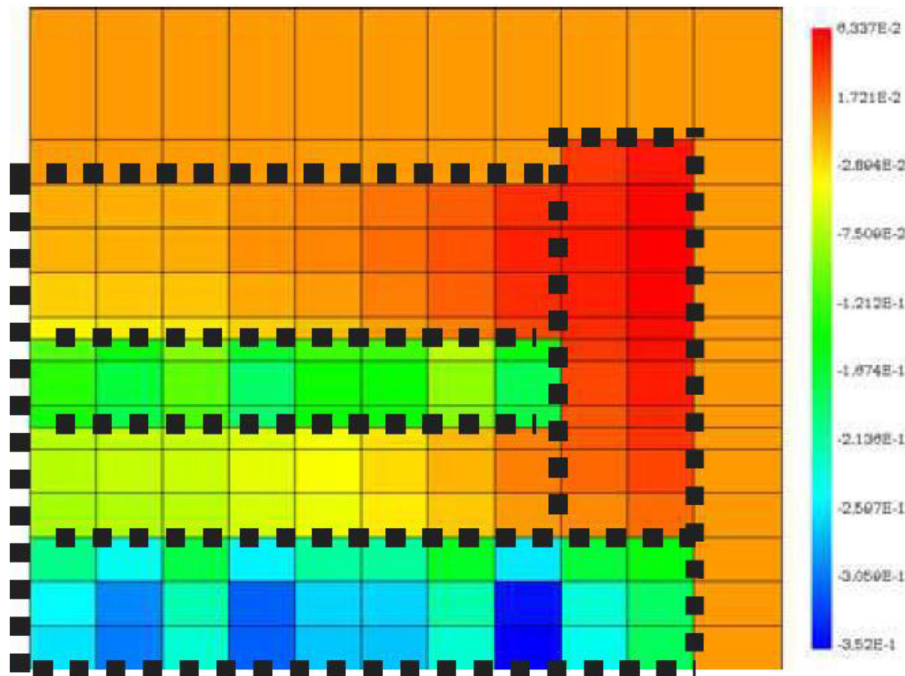
Fig. 7. ASTRID reactor (cid:1) Fissile +fertile partition into 132 regions (cid:1) Sensitivity of the fi ssion source distribution to the 238 U inelastic cross-section.